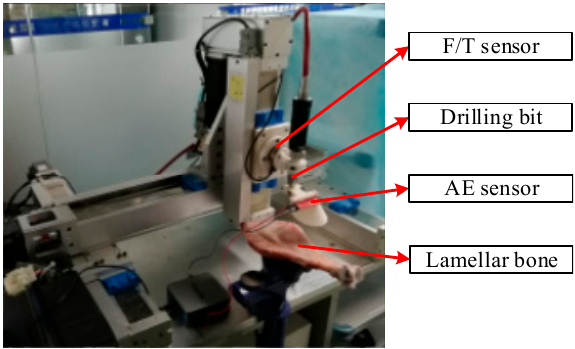
Figure 12. Experimental setup for the drilling process, the drilling bit is used to drill the lamellar bone when the experiment starts, the AE sensor is used to collect the original AE signal and the F/T sensor is used to collect the force and moment signals during the drilling process.